Question: Briefly state, in one sentence, what is plotted here.
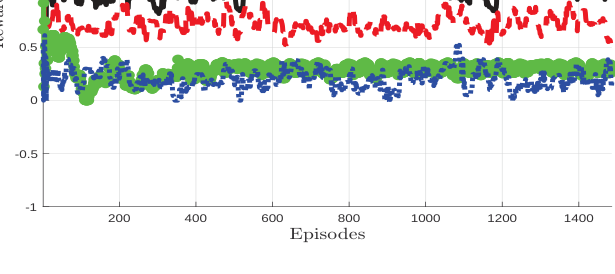
Answer: Convergence of the Meta-DDPG-based algorithm with α = 0.5.